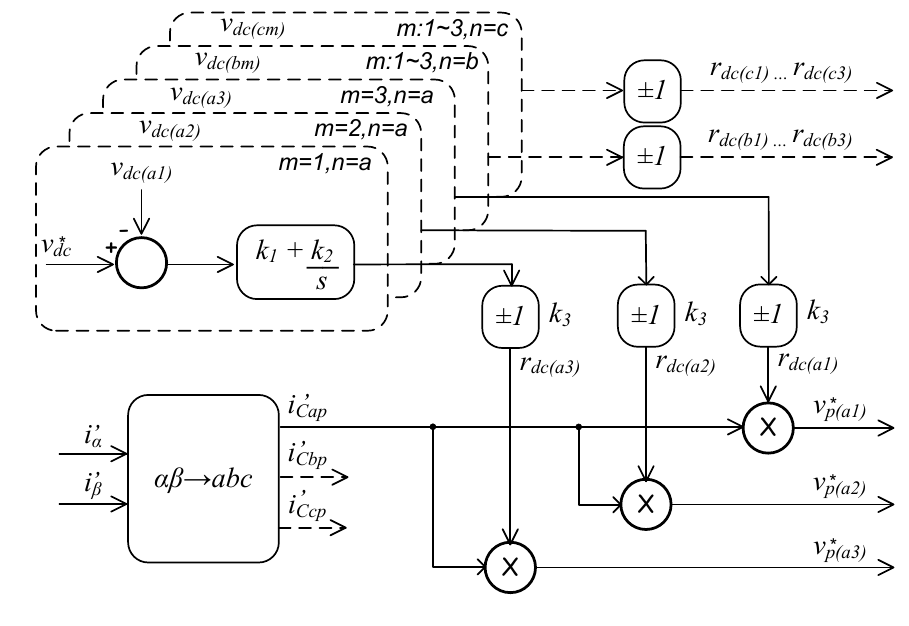
Figure 7. Independent dc link control